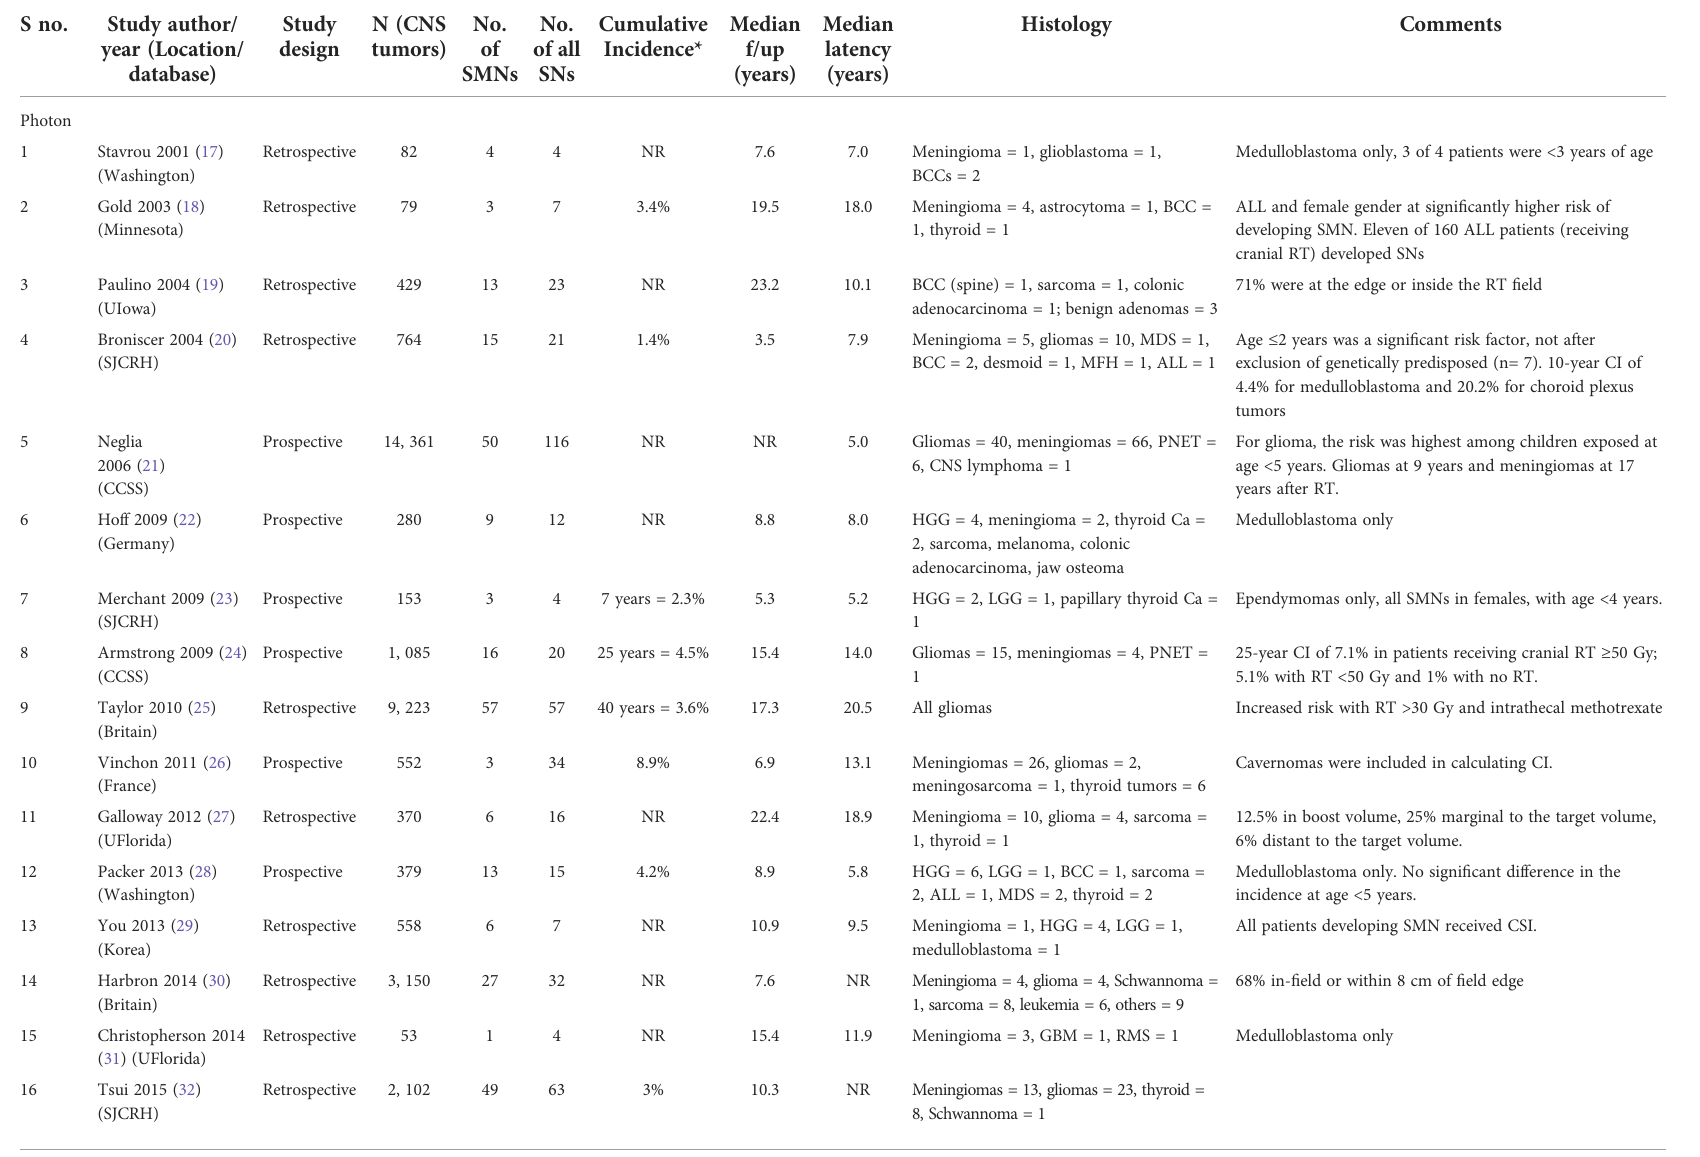
TABLE 1 Summary of studies included in the study